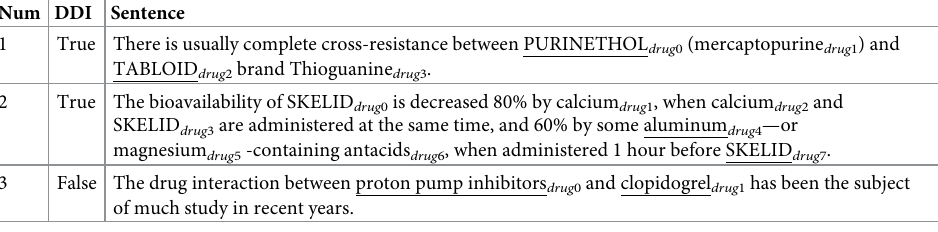
Table 11. Examples of three common types of error